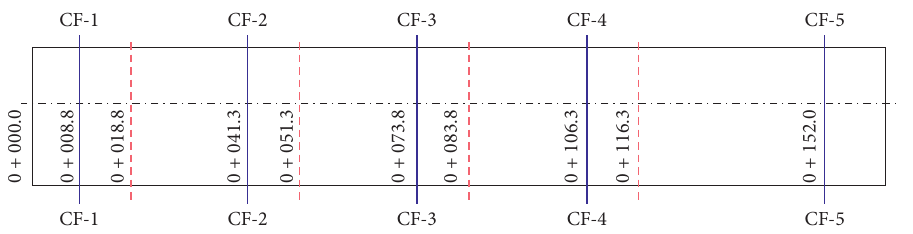
Figure 10: The layout of a designed section of acoustic velocity test in a special elevation in the main powerhouse of Houziyan project.